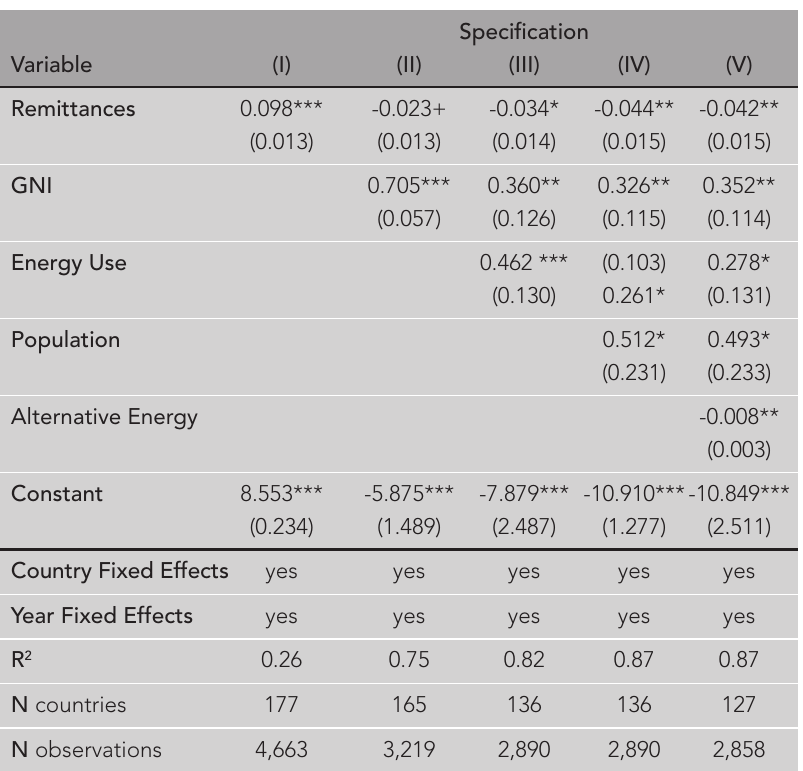
Table 3. Regression Output